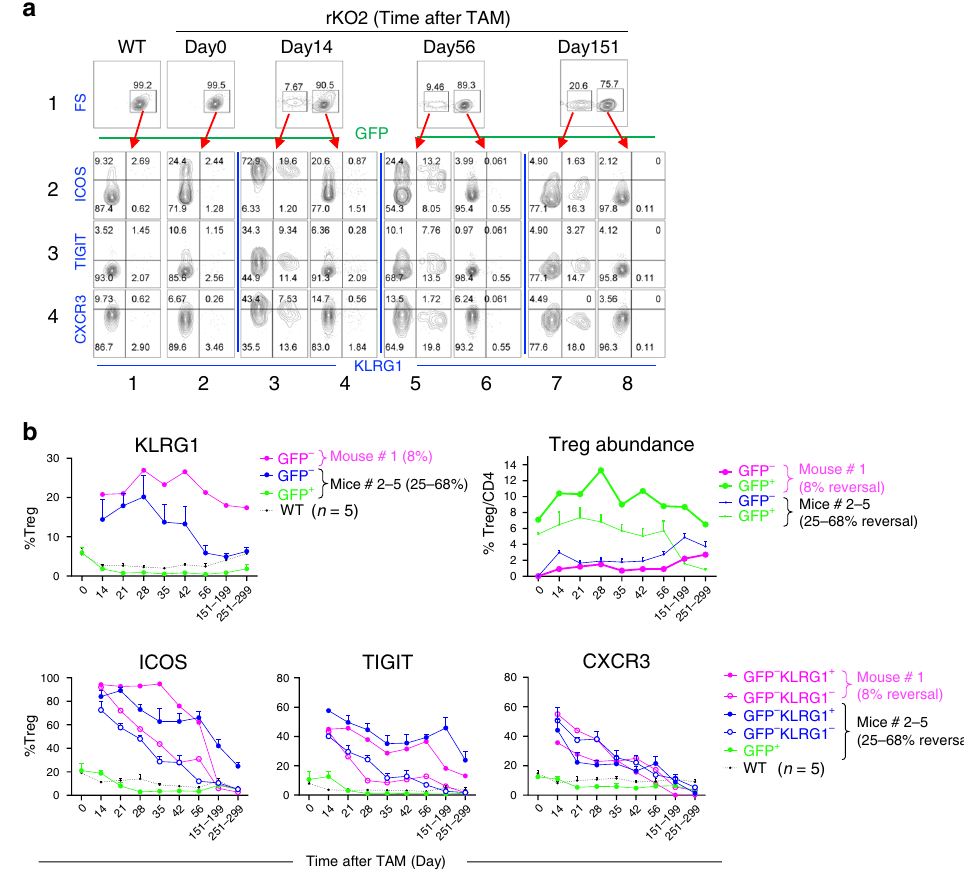
Fig. 6 Fate of SuperTreg cells in vivo. a Peripheral blood cells from the rKO2 mouse with 8% GFP − Tregs (Fig. 2h, thick blue line) were stained with a mixture of CD4, KLRG1, ICOS, TIGIT, and CXCR3 antibodies for the analysis of ICOS, TIGIT, and CXCR3 expression in KLRG1 + and KLRG1 − subsets (rows 2 – 4) within the GFP − (columns 3, 5, and 7) and GFP + (columns 1, 2, 4, 6, and 8) Treg populations. b Summary of the FACS results for the mouse analyzed in a (mouse #1), together with the four other mice in Fig. 2h (#2 – 5). For clarity, only the GFP − subset is displayed for mouse #1 in all the plots, except the top-right plot, and only mean ± SEM is displayed for Mice #2 – 5. As the rKO mice (bearing fi ve to six alleles) were quite rare, the fi ve mice were born and hence analyzed at different times, except for the last two time points when the mice from different litters were analyzed together (the mouse with 8% reversal analyzed on Days 151 and